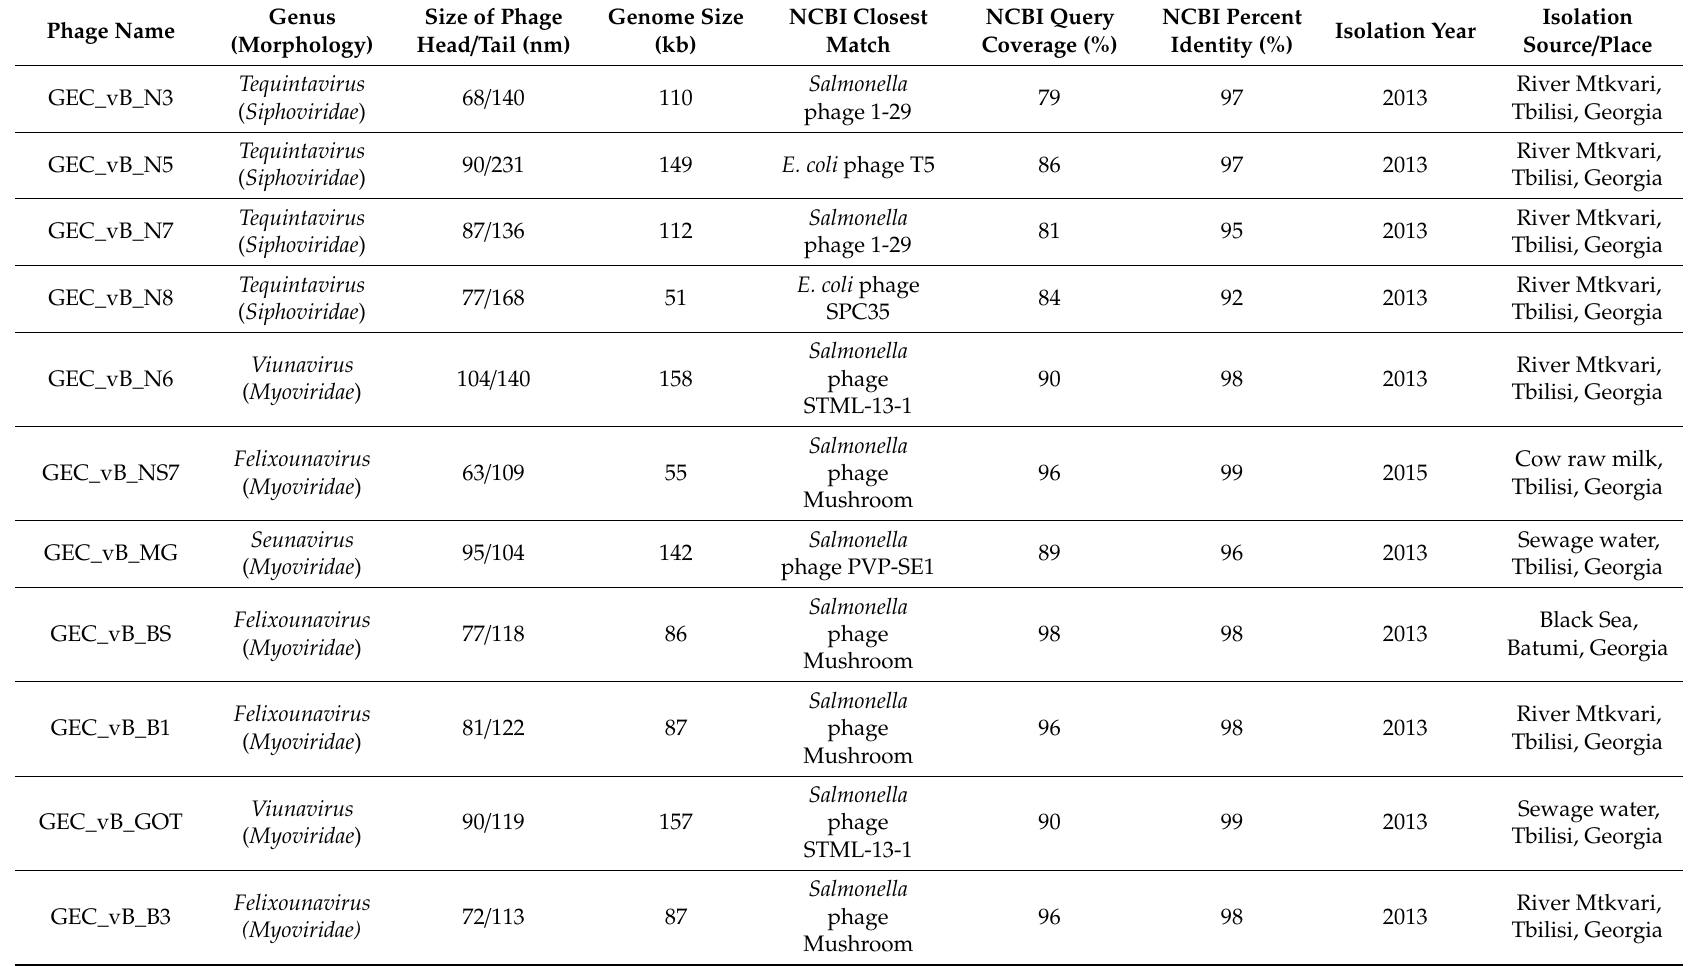
Table 1. List of bacteriophages used in the